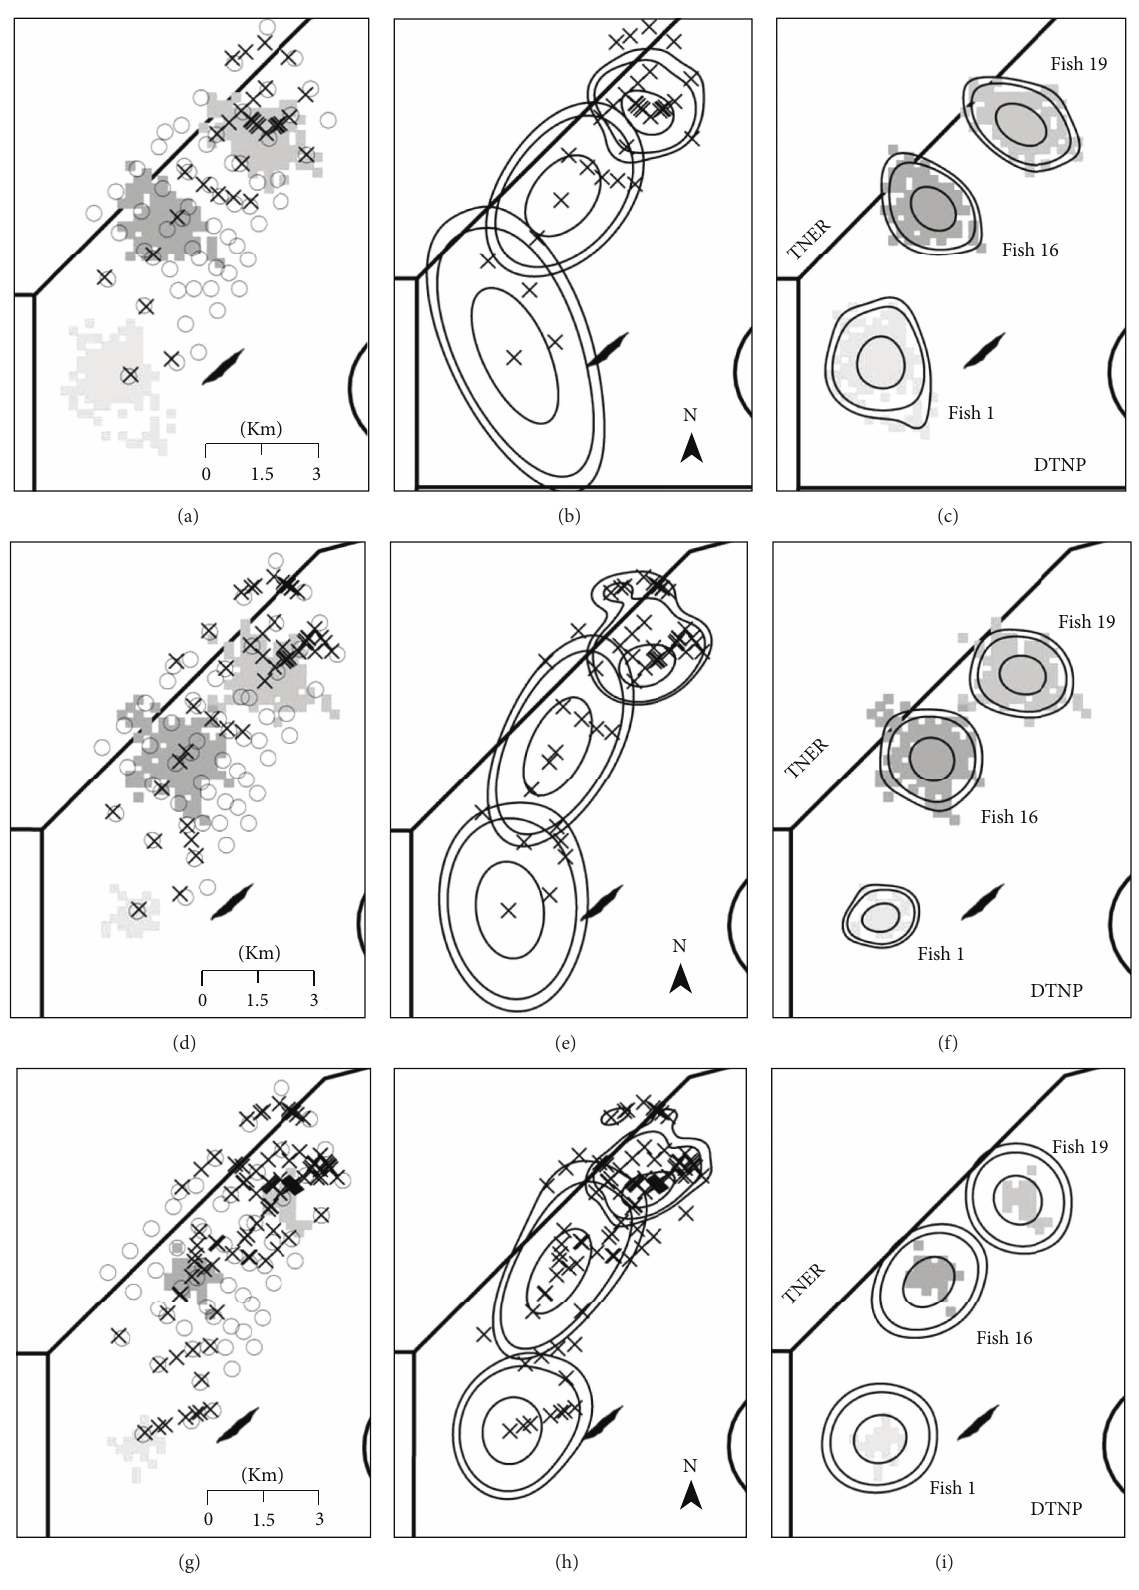
Figure 4: Configuration of simulated acoustic array (white circles) relative to actual path (gray squares) and simulated detections ( × ), with 95%, 90%, and 50% kernel density home ranges for simulated detections and actual simulation path of red grouper (a)–(c), black grouper (d)–(f), and mutton snapper